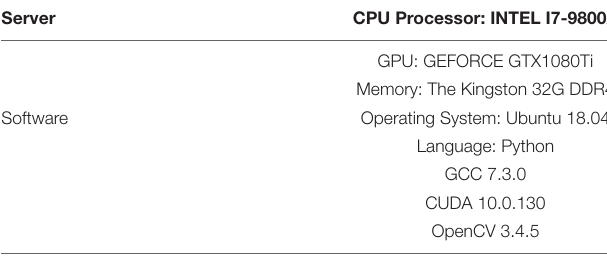
TABLE 4 | Proportion of detection errors (%) for the six algorithms.